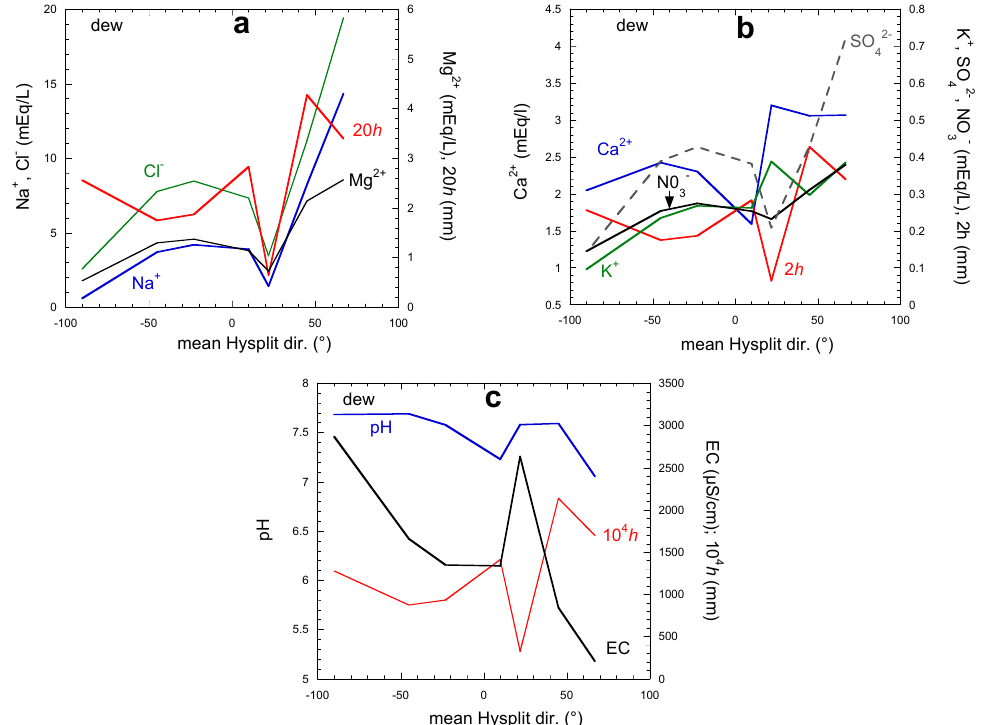
Figure 16. Dew main ions concentrations, electric conductivity, pH and volume per unit area h (mm) correlated variations with the 24 h. mean air mass directions from Hysplit. ( a ) Concentration of main ions of ocean origin (Na + , Cl − , Mg 2+ , in mEq·L − 1 ). ( b ) Concentration of main ions of continental origin (Ca 2+ , K + , SO 42 − , NO 3 − , in mEq·L − 1 ). ( c ) EC and pH. All curves are smoothed fit of single values.